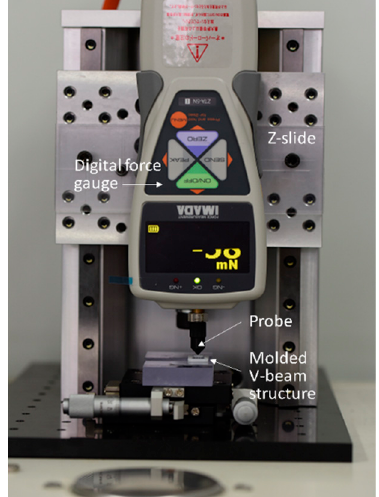
Figure 11. Setup of the force-displacement measurement experiment.